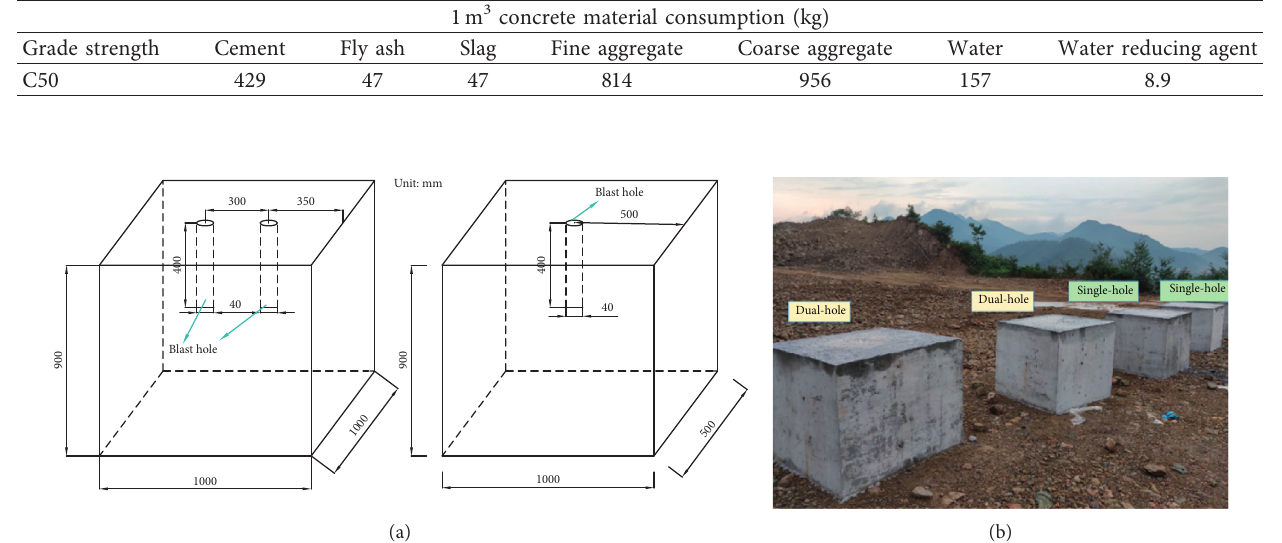
Figure 3: Concrete model test: (a) model size; (b) field model tests.